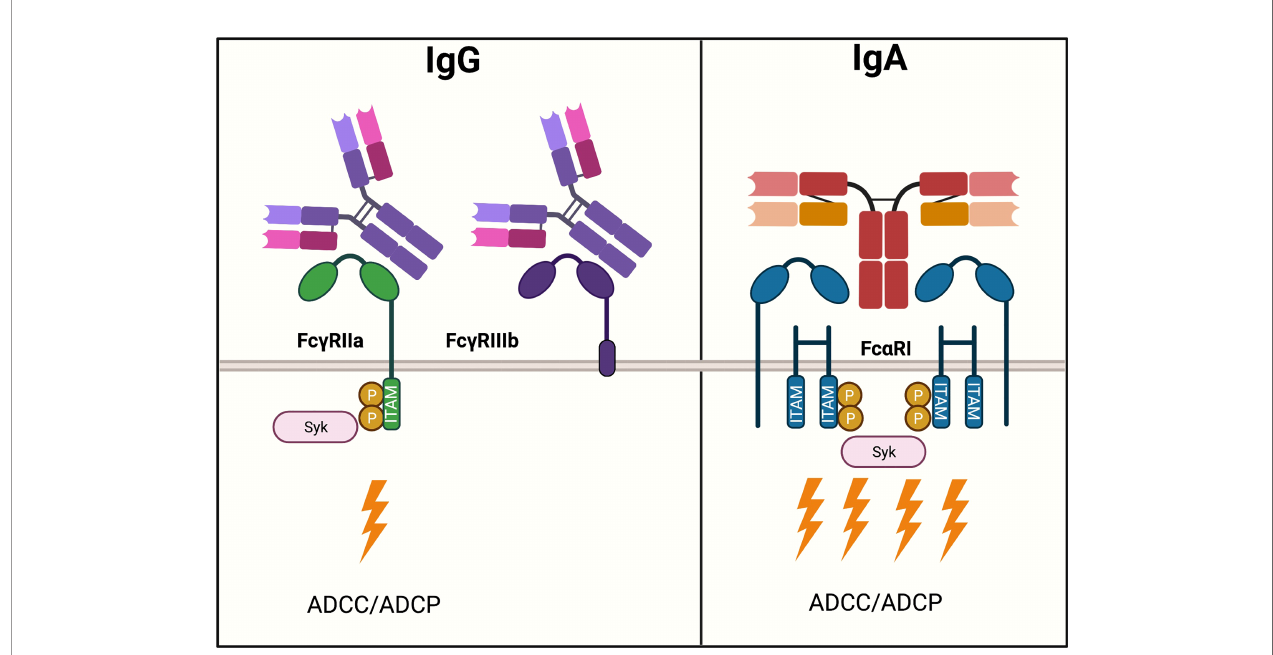
FIGURE 3 | IgG- and IgA-mediated activation of neutrophils. Neutrophils express various Fc receptors, the two most abundant of which, Fc g RIIa and CD16b, are important in modulating activation upon IgG ligation. Fc g RIIb is expressed nearly 9-fold greater than Fc g RIIa. Fc g RIIa is an activating receptor that binds to IgG in a 1:1 stoichiometry and signals via one ITAM motif. Downstream ITAM signaling activates effector functions such as ADCC. Moreover, neutrophils express Fc g RIIb, which lacks an active intracellular signaling domain and functions as a scavenger receptor for IgG. IgA binds to Fc a RI expressed on neutrophils, an activating Fc receptor in a 1:2 stoichiometry. A total of four ITAMs cause a strong activation of